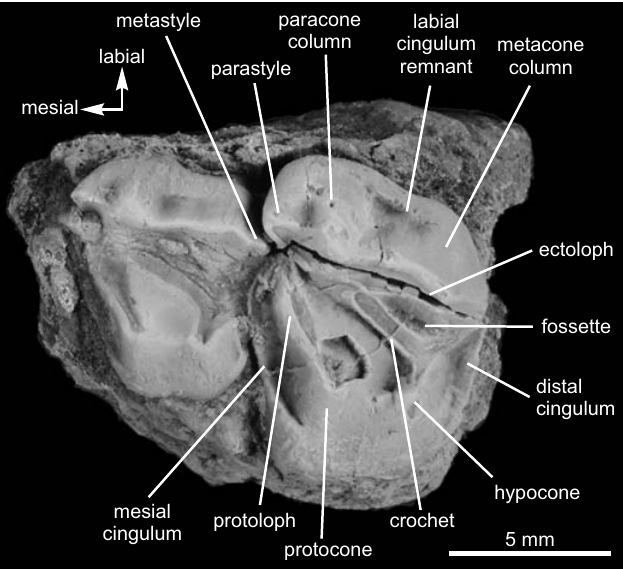
Fig. 3. Holotype of notoungulate mammal Orome deepi gen. et sp. nov. (MLP-90-II-5-1631) from the early Eocene of Las Violetas Farm, Argentina. Left dP4 and M1 in occlusal view.